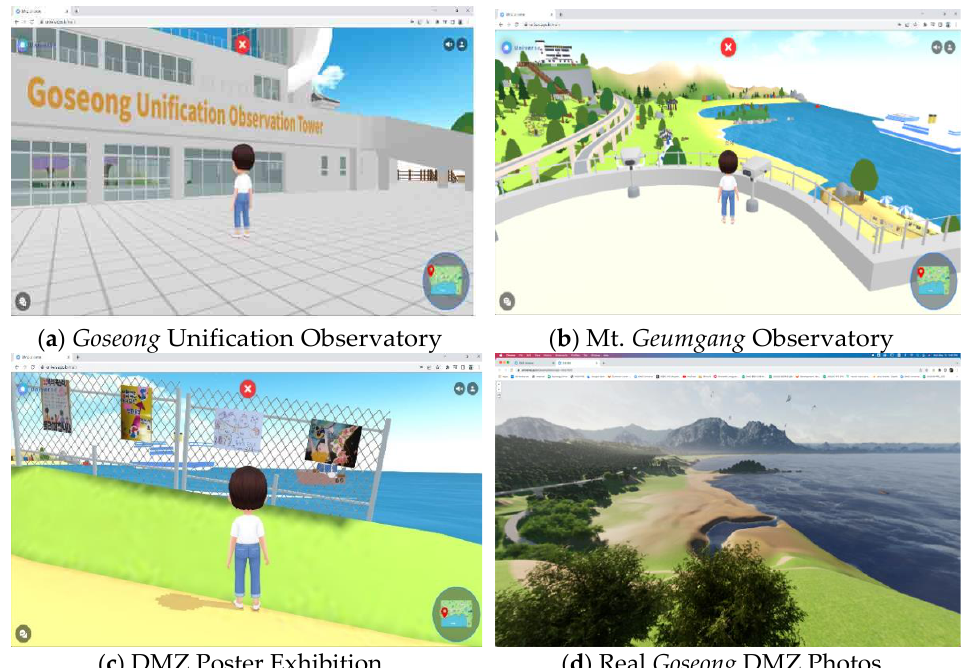
Figure 15. Goseong DMZ.